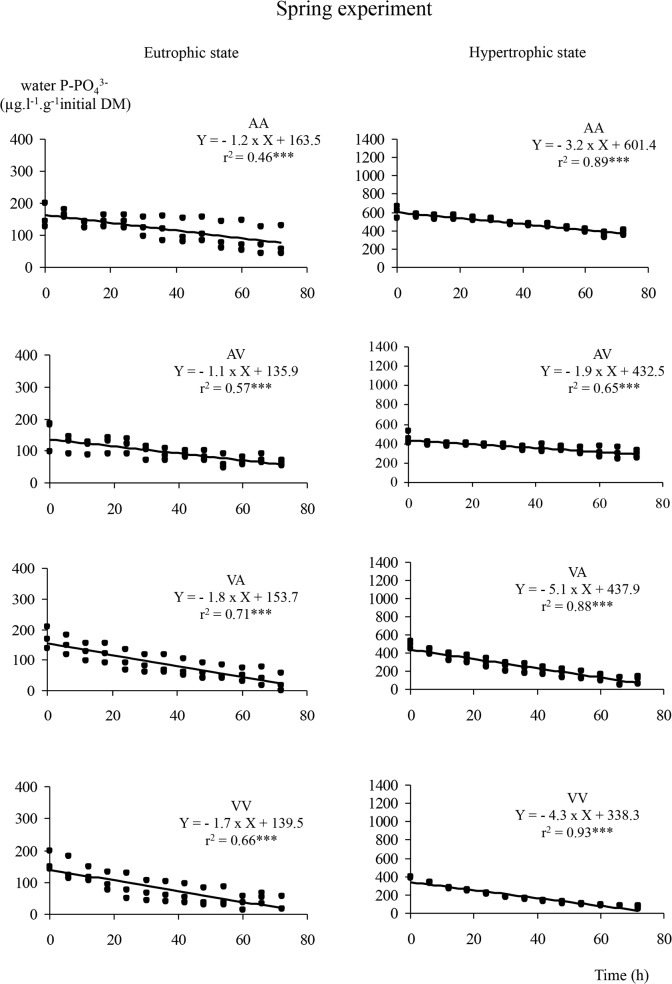
Dynamics of water phosphorus in spring.Dynamics of water phosphorus (in μg.l−1.g−1 of plant initial dry mass) and results of a linear model regression analyses under eutrophic and hypertrophic conditions, for all the possible combinations of water and subpopulation, during the spring experiment. In the legend, AA, AV, VA, VV include the information on the treatment, the first letter refers to the type of water and the second one to the subpopulation (e.g. AV means Alsatian water and Vosgian subpopulation).